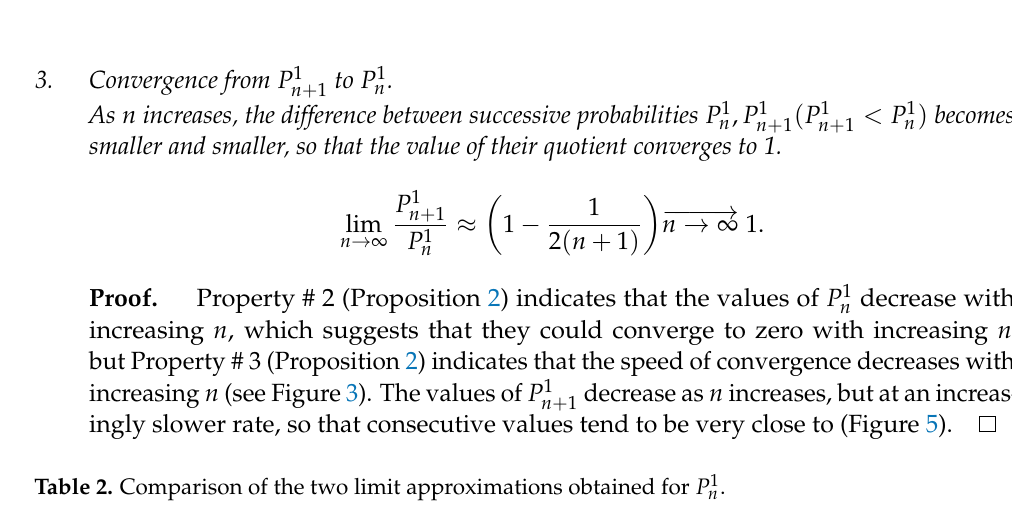
Table 2. Comparison of the two limit approximations obtained for P 1 n . n